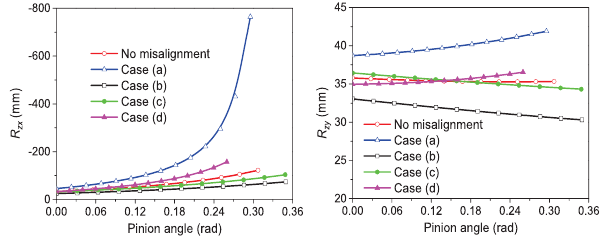
Fig. 7 Radii of curvatures axes of contact ellipse.